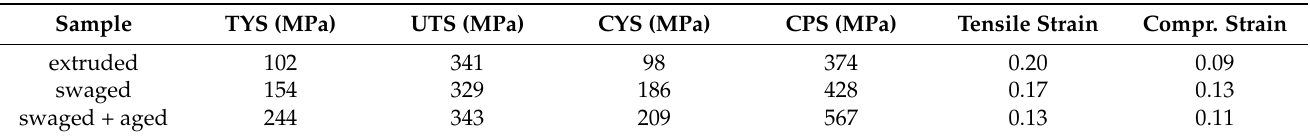
Table 1. Deformation characteristics of extruded and swaged samples.